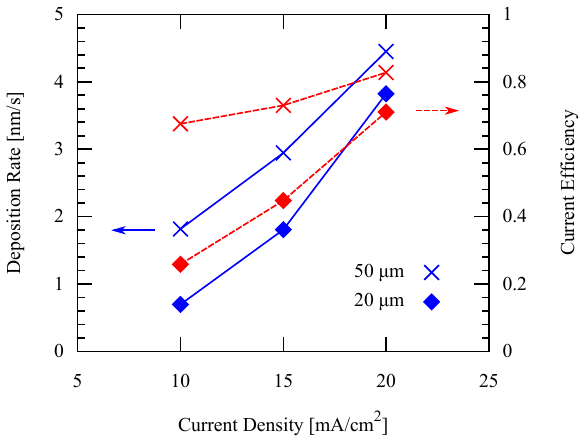
Figure 15. Deposition rate and current efficiency using different current densities applied with different pattern widths on an Al seed